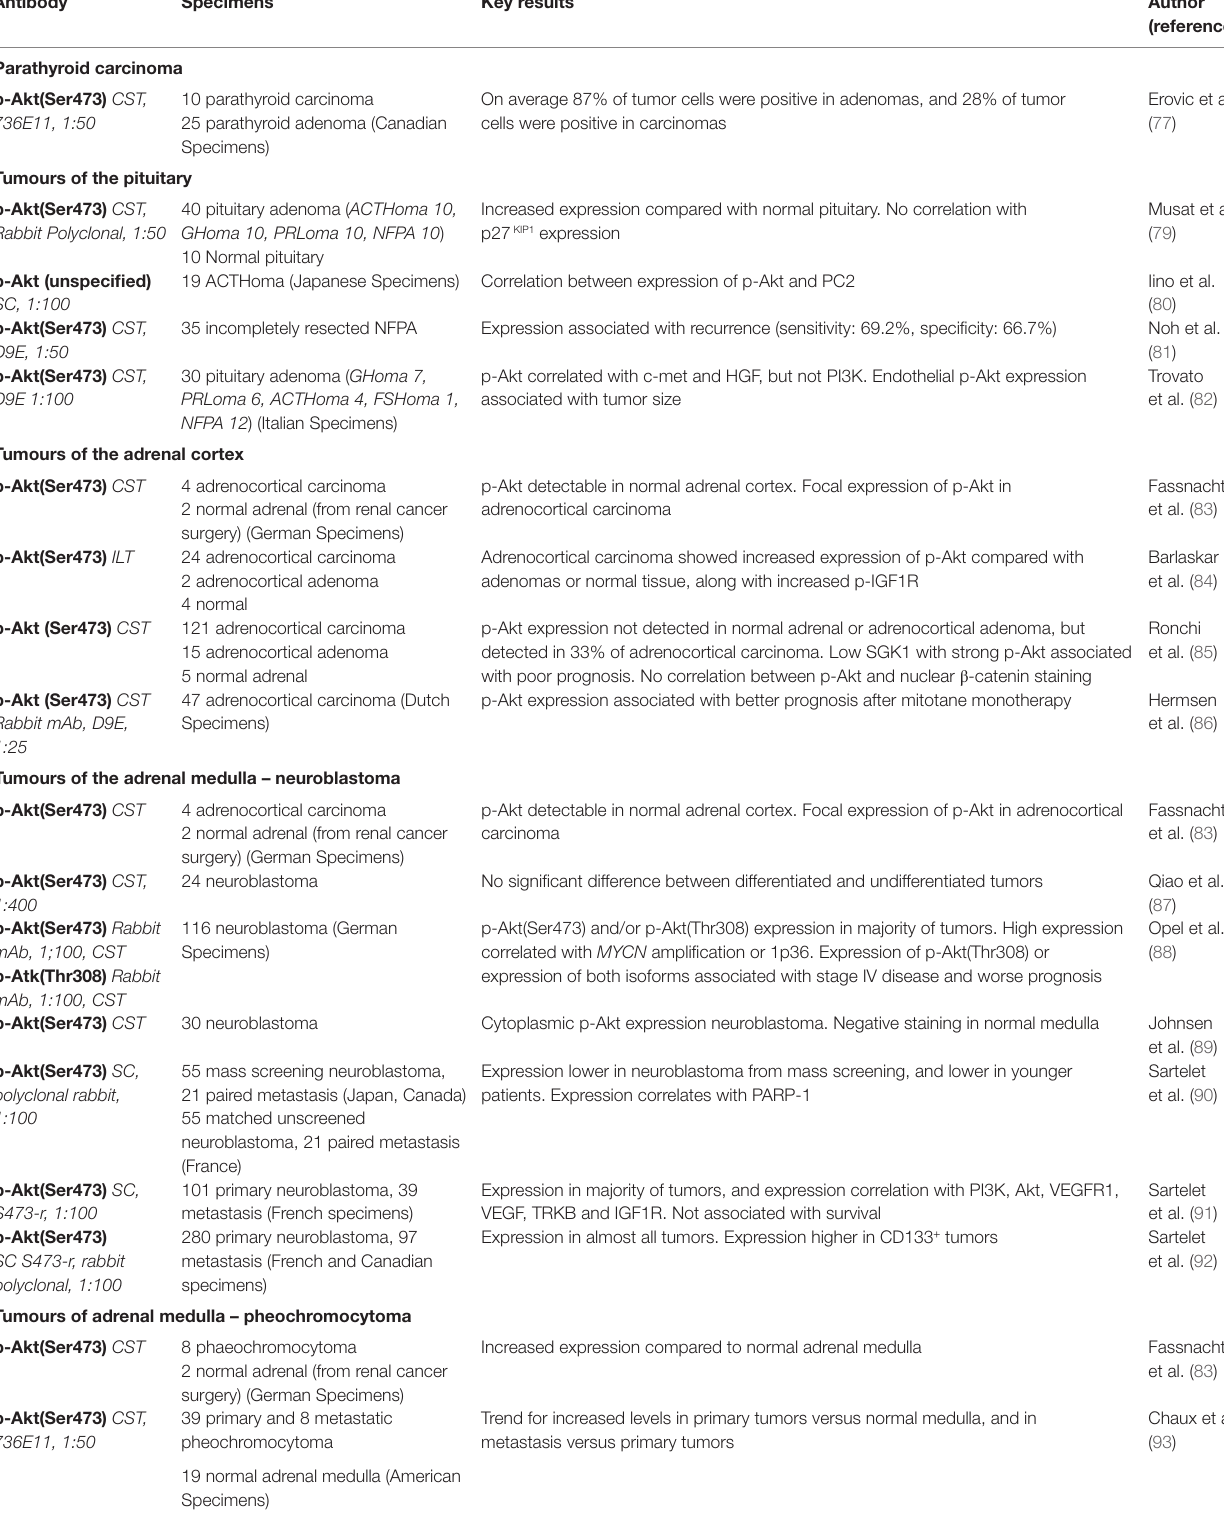
TABLe 2 | Results of immunohistochemical staining studies for p-Akt(Ser473) in non-thyroid tumors of endocrine tissue origin.